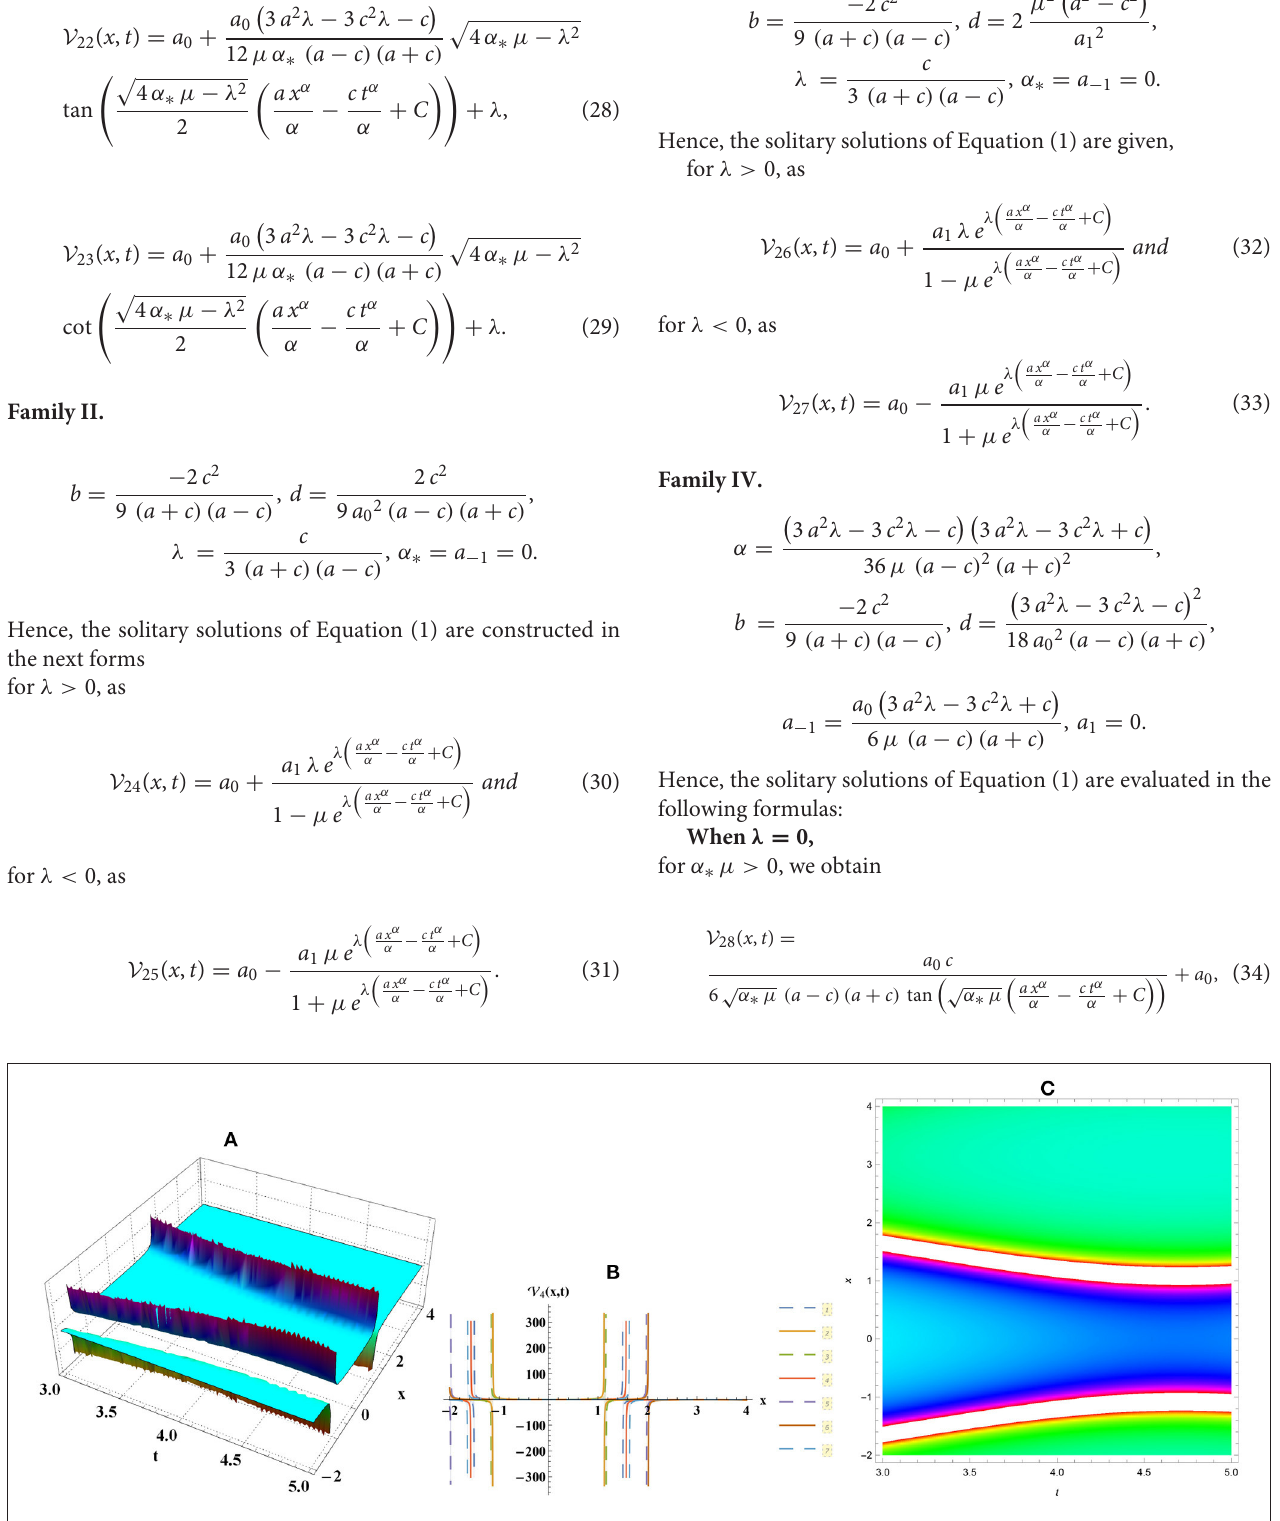
Frontiers in Physics |